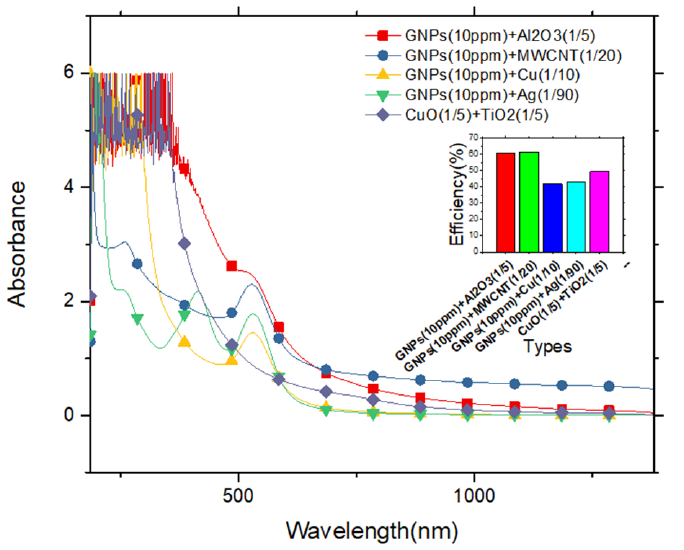
Figure 12. The absorption spectrum and light–to–heat conversion efficiency of the hybrid nanofluid. The absorption efficiency of all nanofluids within the wavelength between 200 and 3000 nm is calculated by the Equation (3). The calculation results of the light–to–heat conversion efficiency of GNPs (10 ppm) +MWCNT (1/20), GNPs (10 ppm) +Al 2 O 3 (1/5), GNPs (10 ppm) +Ag (1/90), GNPs (10 ppm) +CuO (1/10), CuO (1/5) +TiO 2 (1/5)